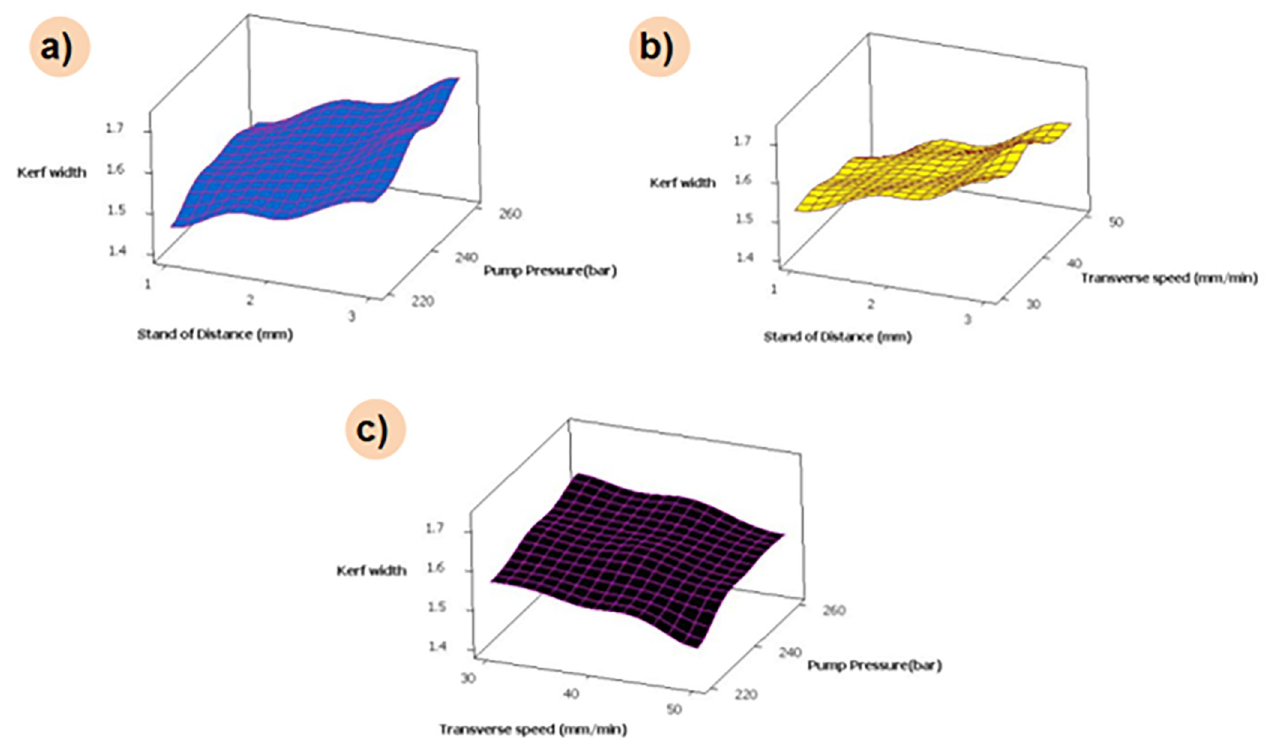
Fig 11. Influence of AWJM parameters on kerf width for 0.2 wt. % of filler loaded composite. https://doi.org/10.1371/journal.pone.0270505.g011 Table 9. Response table for 0.3 wt. % of filler loaded composite. Level Pump Pressure (bar)